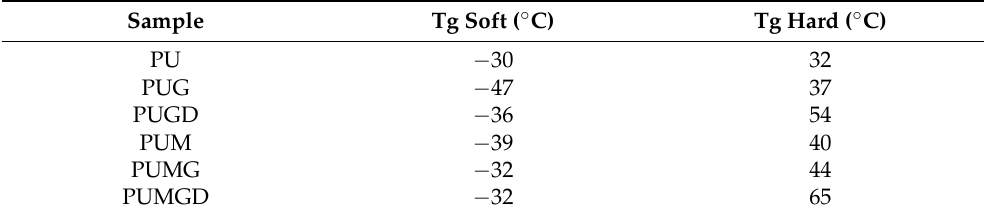
Table 4. Glass-transition temperature values obtained by DSC analysis for polyurea and its nanocom- posites.